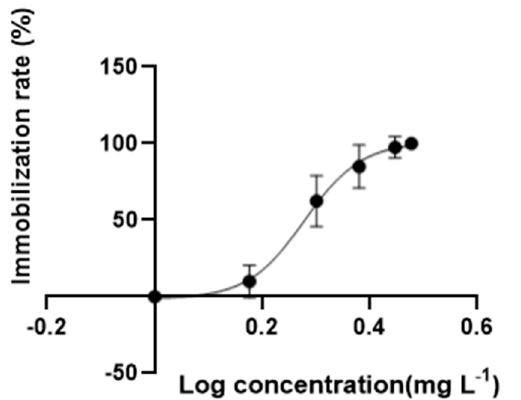
Figure 1. The immobilization rate of DES during 48 h test. Data are mean ± SD ( n = 8).